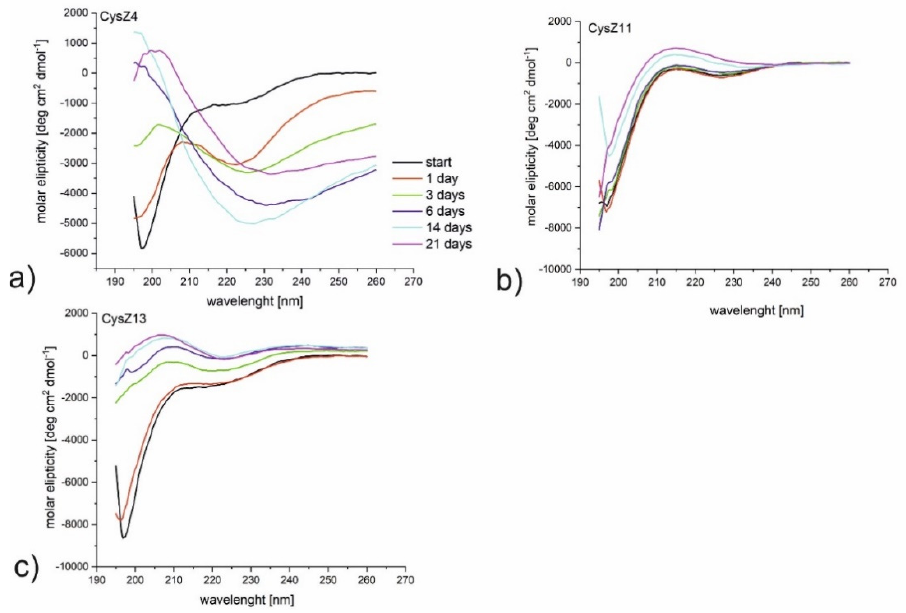
Figure 3. CD spectra for the peptides ( a ) CysZ4, ( b ) CysZ11, and ( c ) CysZ13 after 21 days incubation at a concentration of 1 mg/mL in PBS pH 7.4. at a concentration of 1 mg/mL in PBS pH